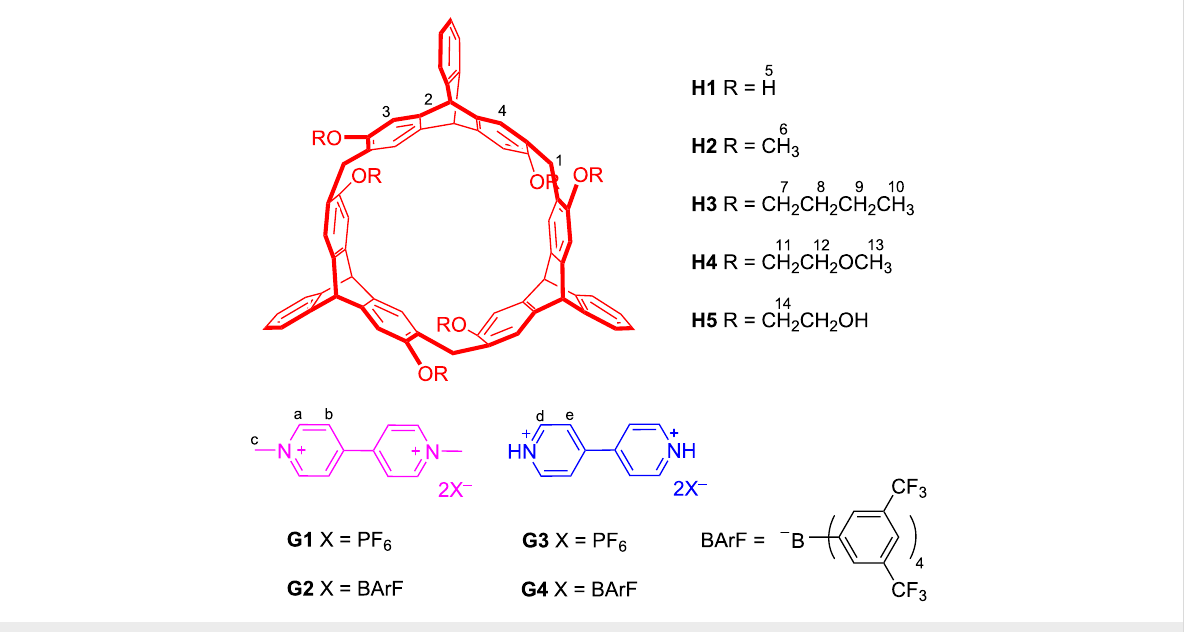
Figure 1: Structures and proton designations of hosts H1 – 5 and guests G1 – 4